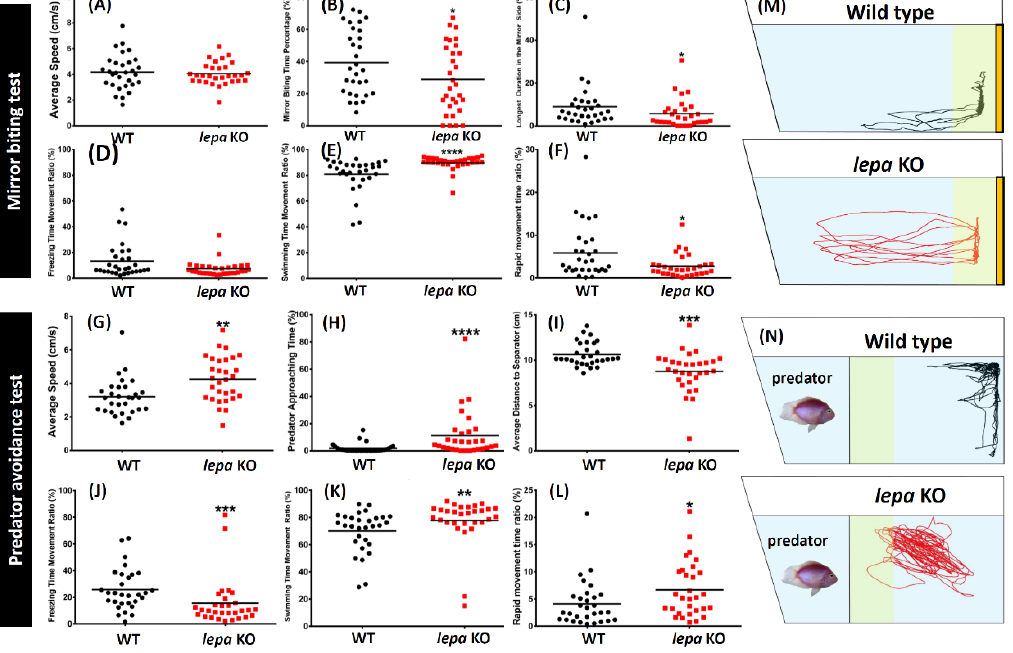
Figure 3. Comparison of several behavior endpoints of untreated wild type and lepa KO zebrafish in mirror biting test ( A – F ) and predator avoidance test ( G – L ): ( A ) average speed; ( B ) mirror biting time percentage; ( C ) longest duration in the mirror side; ( D ) freezing time movement ratio; ( E ) swimming time movement ratio; ( F ) rapid movement time ratio; ( G ) average speed; ( H ) predator approaching time; ( I ) average distance to separator; ( J ) freezing time movement ratio; ( K ) swimming time movement ratio; and ( L ) rapid movement ratio. ( M ) Locomotion trajectory of wild type (black color) and lepa KO (red color) zebrafish in mirror biting test. The mirror positions are positioned to the right site. The mirror approaching zones are highlighted in yellow color. ( N ) Locomotion trajectory of wild type (left) and lepa KO (right) zebrafish in predator avoidance test. The predator is placed in the left side and zebrafish is placed in the right site and one transparent glass plate is inserted to separate both animals. The predator approaching zones are highlighted in yellow color. The data are expressed as the mean ± SEM and were analyzed by Mann–Whitney test ( n = 30; * p < 0.05, ** p < 0.01, *** p < 0.001, **** p < 0.0001).